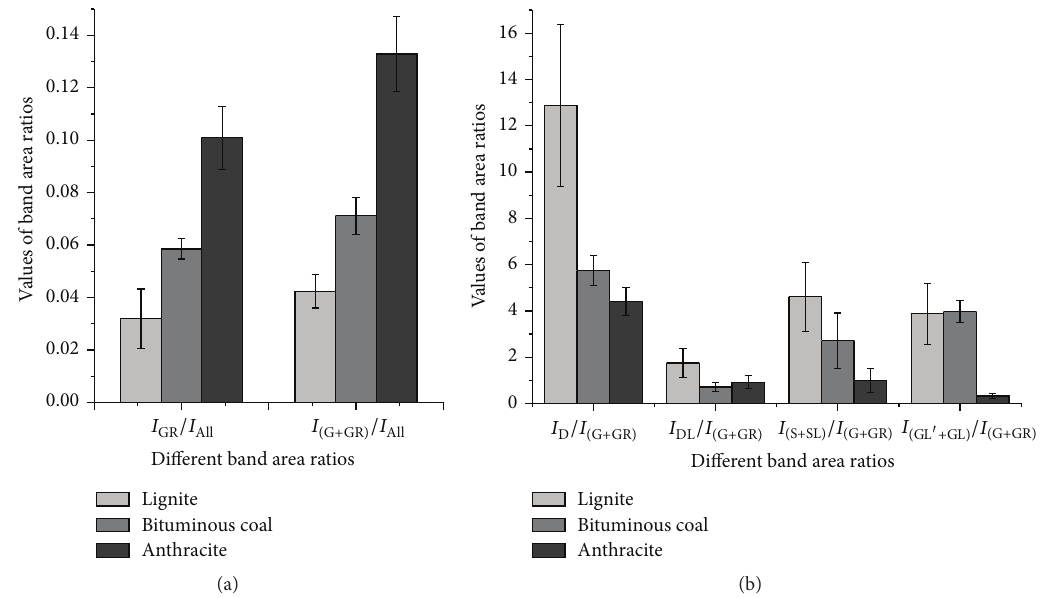
/𝐼 /𝐼 /𝐼 𝐼 /𝐼 𝐼 /𝐼 and 𝐼 ( and (b) 𝐼 ( G + GR ) , ( G + GR ) , ( S + SL ) ( G + GR ) , and GR All G + GR ) All D DL